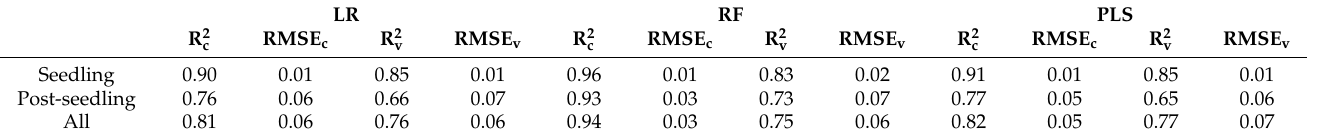
Table 6. Prediction results of LR, RF, and PLS with the optimal texture subset across all different growth stages.